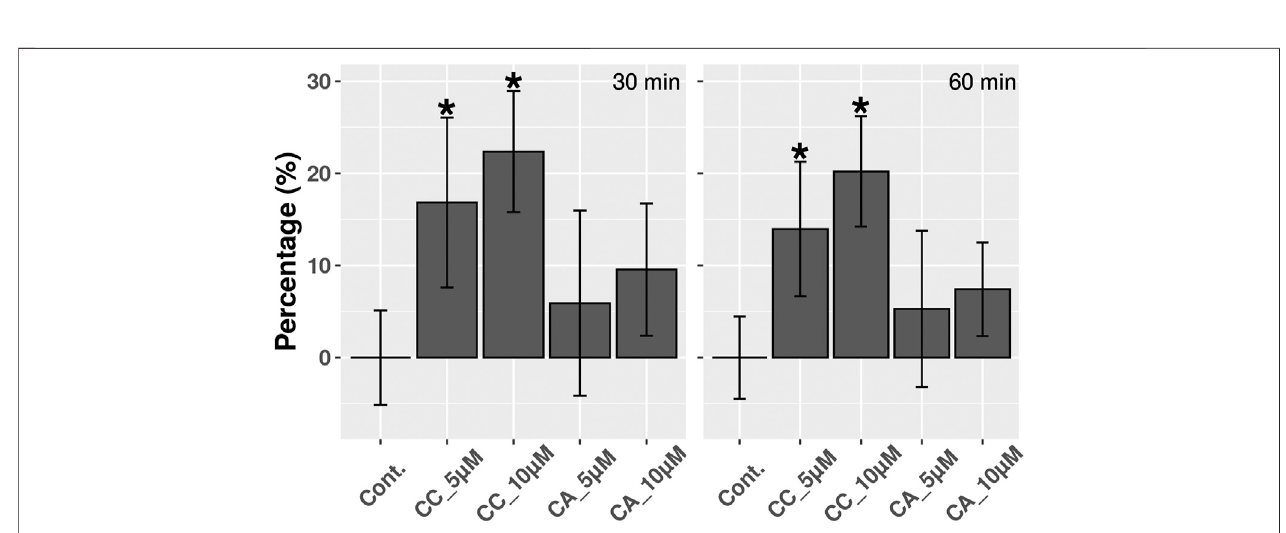
FIGURE4 | NOdetection in HepG2 cells treated with 5 and 10 µM CC and CAduring 30and 60 min. Resultsare expressed as percentages and differences were considered signi fi cant (*) when p < 0.01 ( n (cid:2) 3).